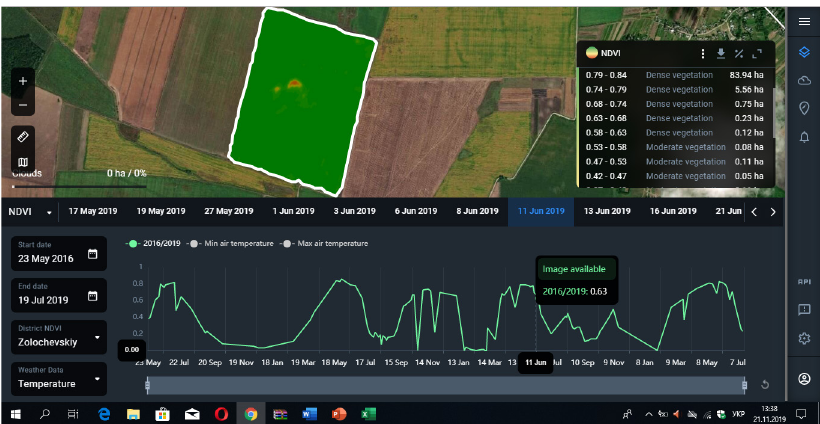
Figure 3. Image of the NDVI curve of annual flow for 2016–2019 and the state of land use according to the vegetation index as of June 11,